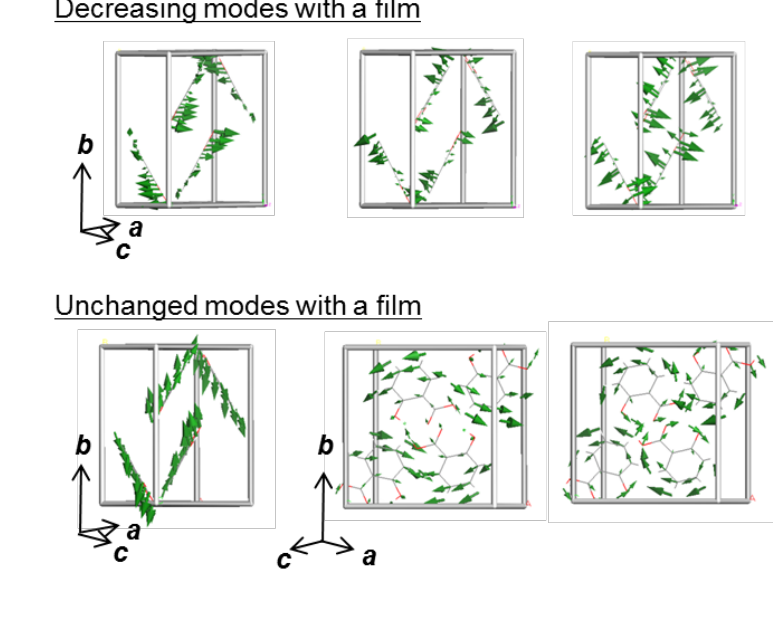
Figure 11. Displacement vectors of the decreasing and unchanged modes with a film of aspirin